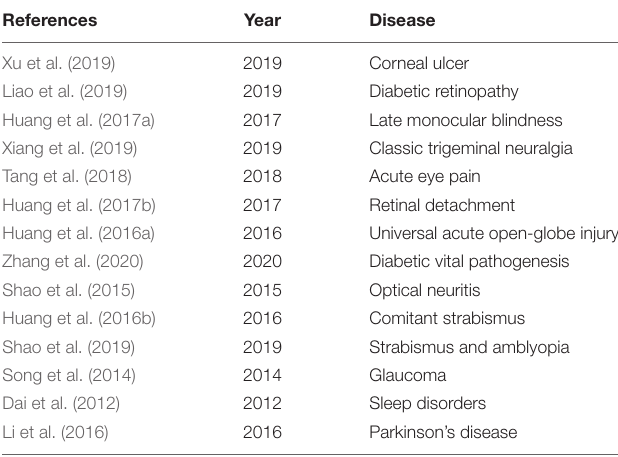
TABLE 3 | Regional homogeneity method applied in ophthalmological diseases.